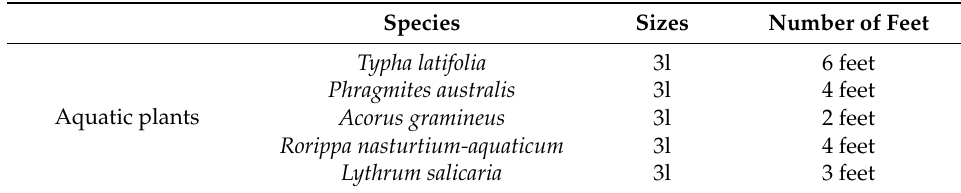
Table 7. Aquatic species selected to be planted in the subfield